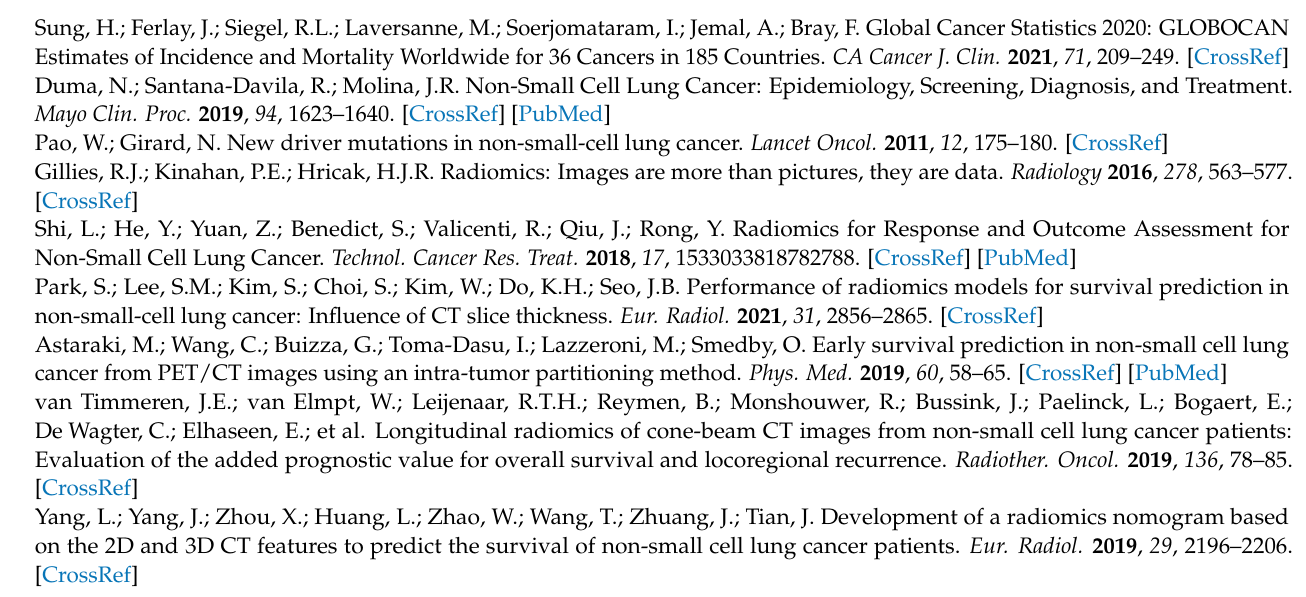
Table S2. Testing-set-LUNG1-Radiomics. Table S3.